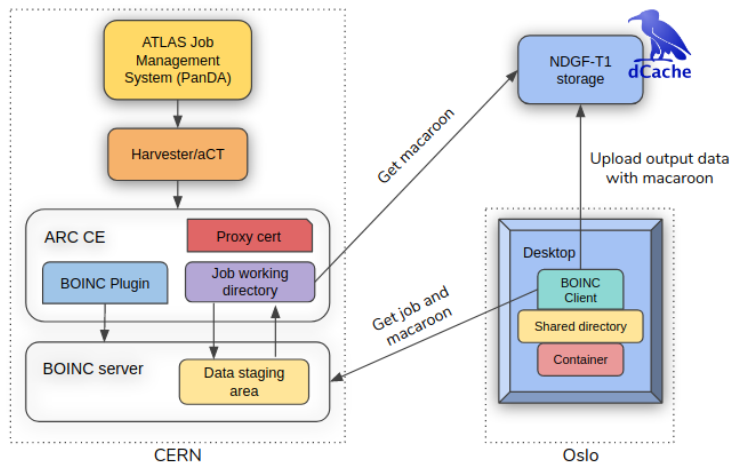
Figure 4. ATLAS@Work